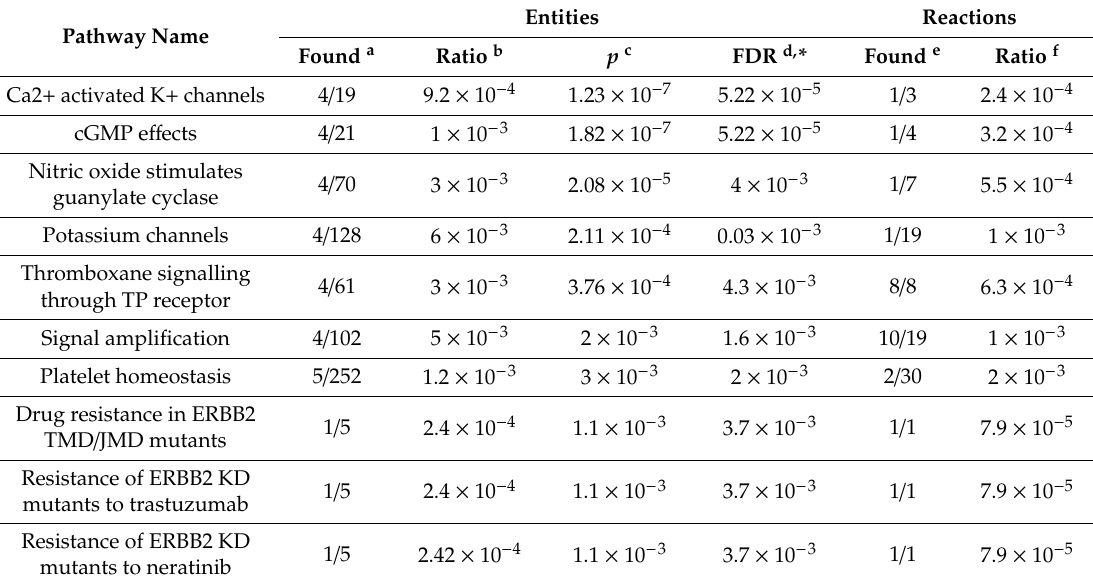
Table 7. Pathway enrichment analysis for genes of the direct genetic e ff ects for calf weight at four months network. The following table shows the 10 most relevant pathways sorted by p